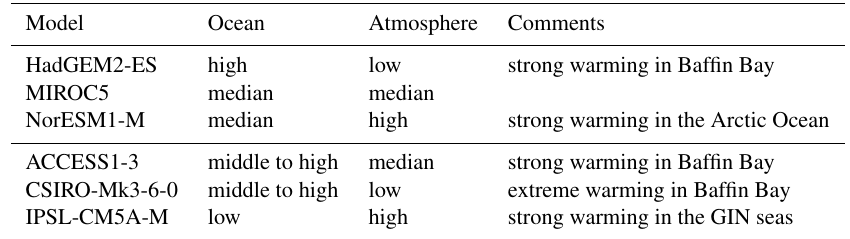
Table 3. Selected AOGCMs for Greenland and their qualitative projected